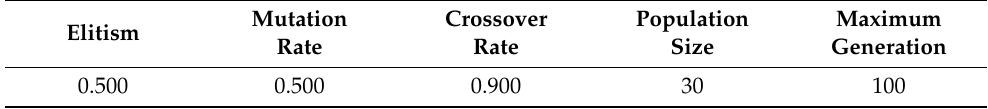
Table 3. Settings of the optimization algorithm.